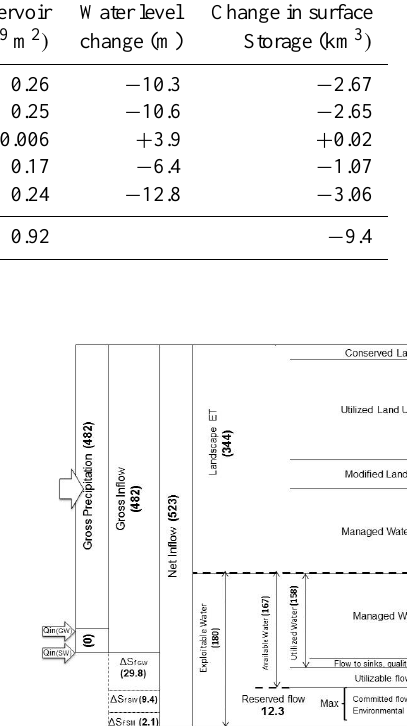
Fig. 3. WA + resource base sheet for the Indus basin during 2007. All components are in km 3